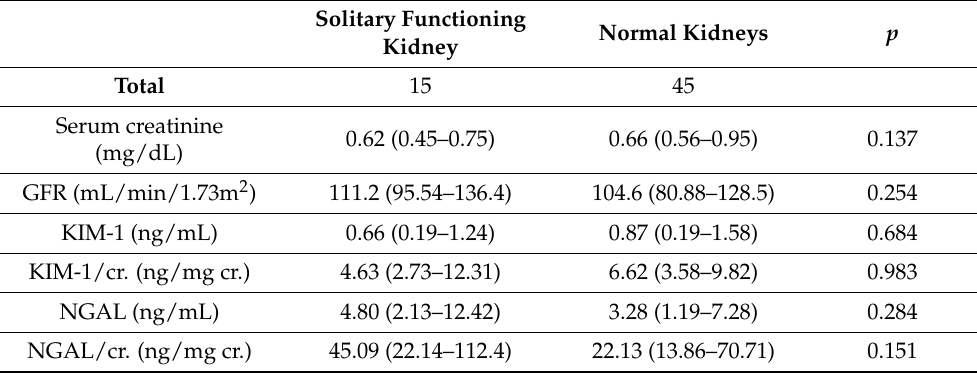
Table 5. Urine concentration of biochemical parameters in survivors of solid tumors with solitary functioning kidney and normal kidney.